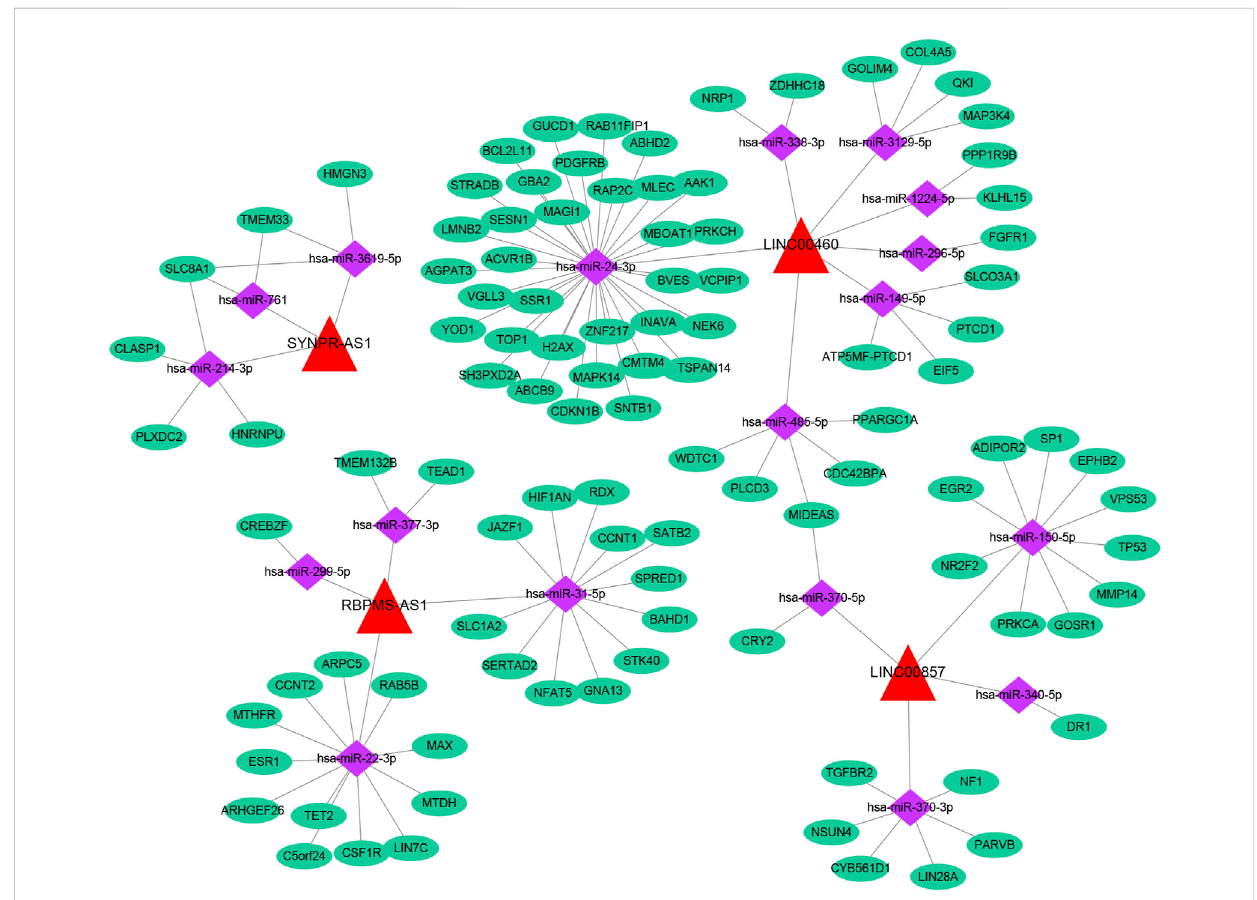
FIGURE 7 A lncRNA-miRNA-mRNA ceRNA network containing 125 nodes and 125